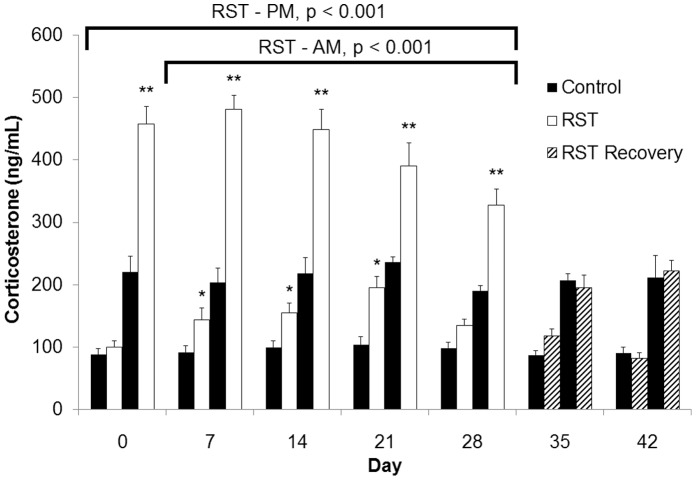
Prolonged RST elevated corticosterone levels throughout the stress period.Corticosterone levels were determined during the stress period (solid bars, Day 0–28) and following stress cessation (hashed bars, Day 29–42). For each data point, n = 5–15 individuals. Data shown is mean +SEM. *p<.05; **p<.0001. Data were collected without repeated sampling of individuals.